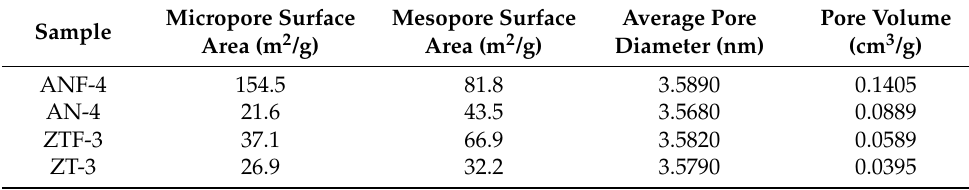
Figure 9. N 2 adsorption–desorption isotherm ( a ) and pore size distribution ( b ) of catalysts.